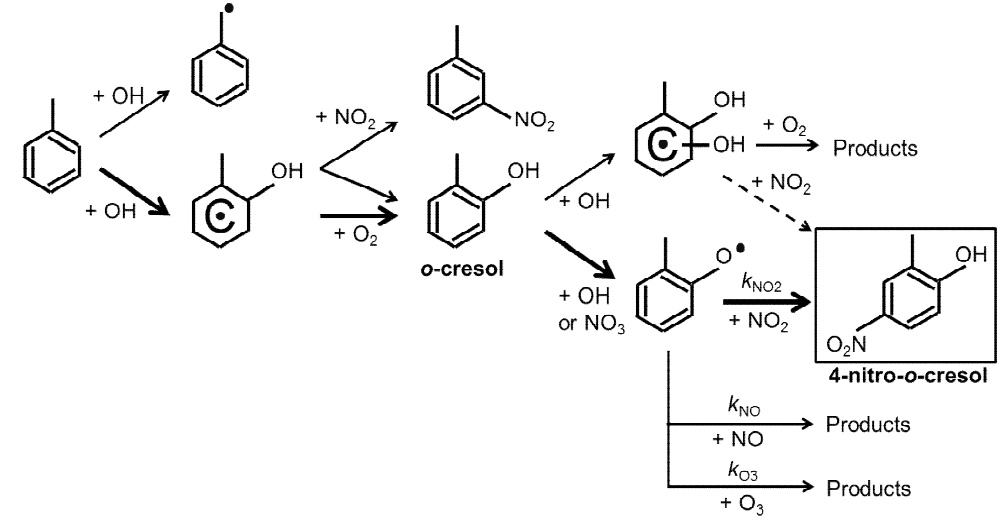
Fig. 7. One of the significant reaction schemes for the formation of nitrocresols during photooxidation of toluene in the presence of NO x . The bold arrows indicate the major reaction paths leading to formation of 4-nitro- o -cresol under our experimental conditions.